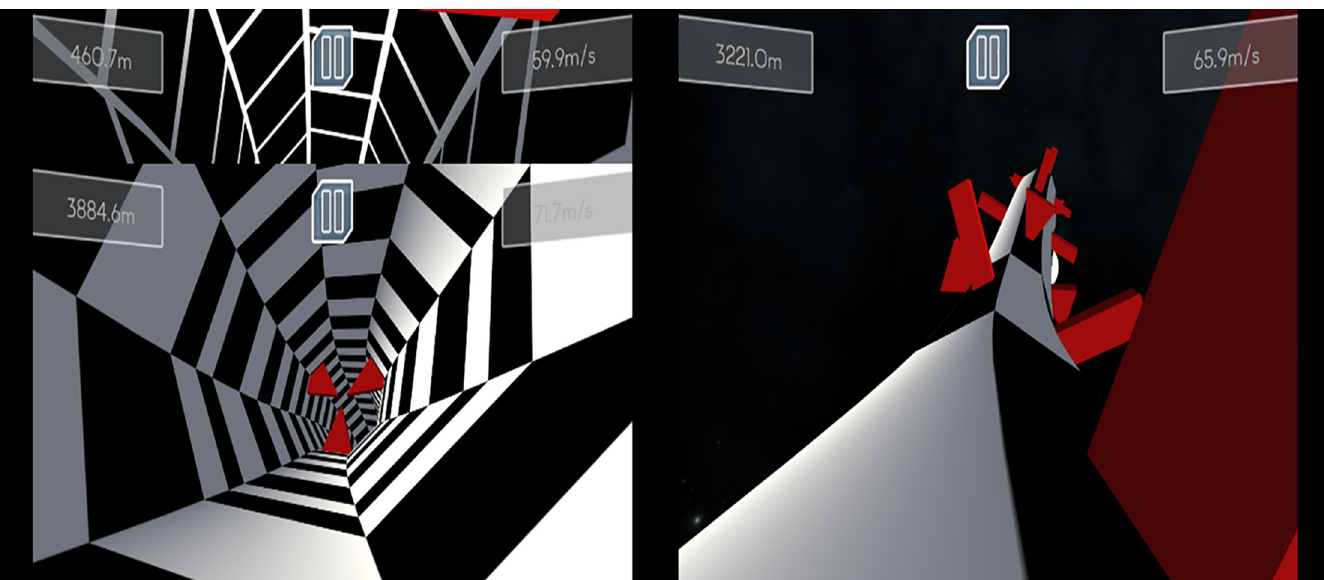
Fig 2. Concept of the 3D game: The player controls a space ship from a first-person perspective flying through the inside of a tube or on the outside of a tube.